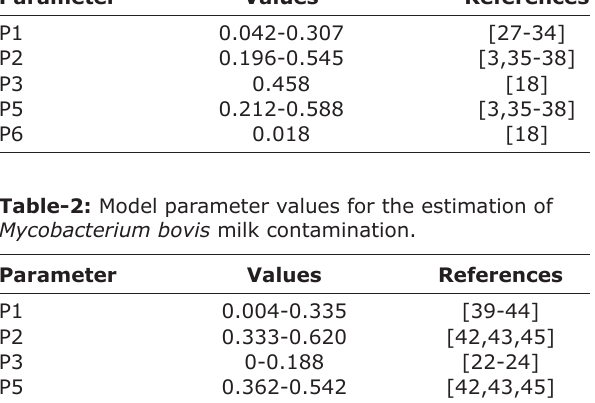
Table-1: Model parameter values for the estimation of Brucella milk contamination. Parameter Values